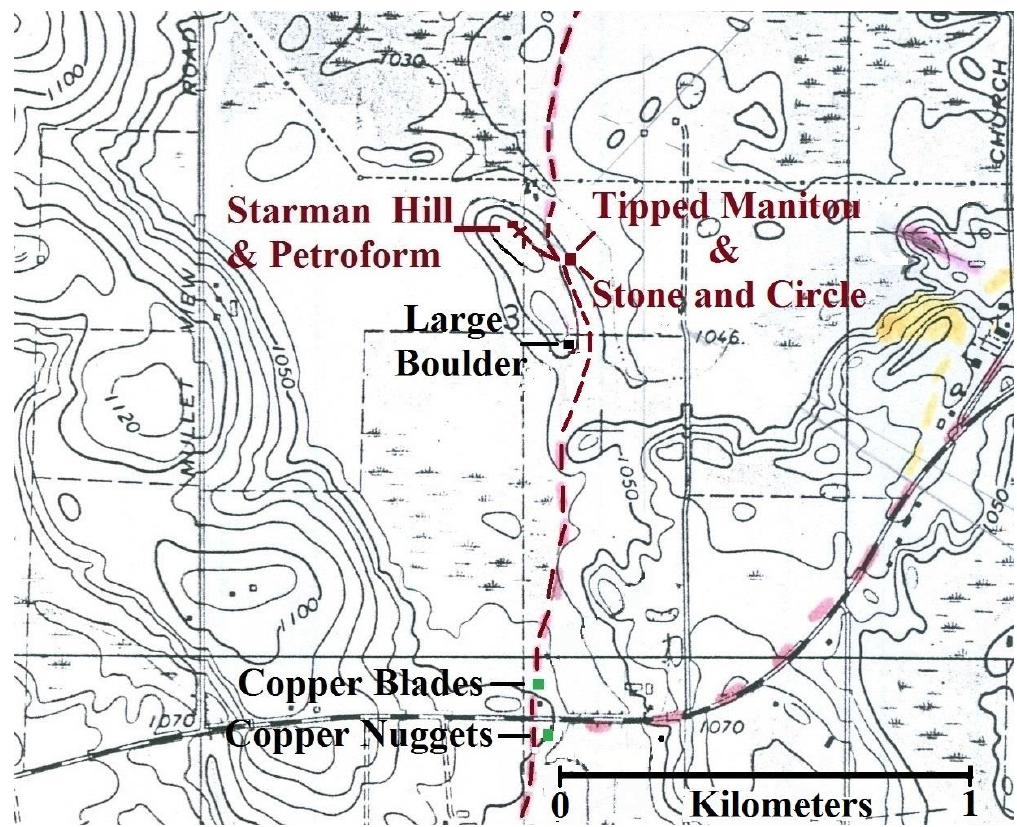
Figure 3. Portion of a United States Department of the Interior Geologic Survey, Dundee Quadrangle, Wisconsin, 7.5 Minute Series (Topographic) map showing the Starman hill, trail (dashed line), tipped Manitou stone and where refined copper nuggets and a copper blade were found. Contour lines are at 10 foot intervals.